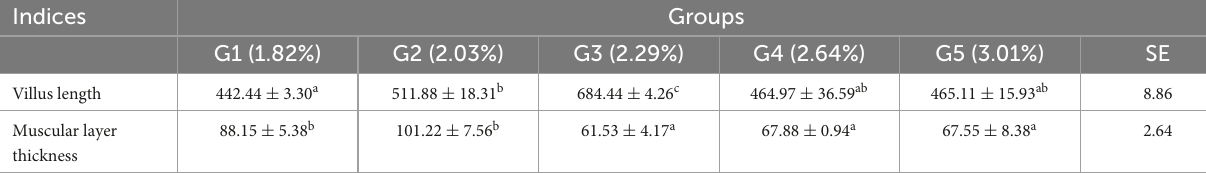
TABLE 10 Effects of dietary phenylalanine levels on the intestinal morphology of triploid O. mykiss ( µ m).